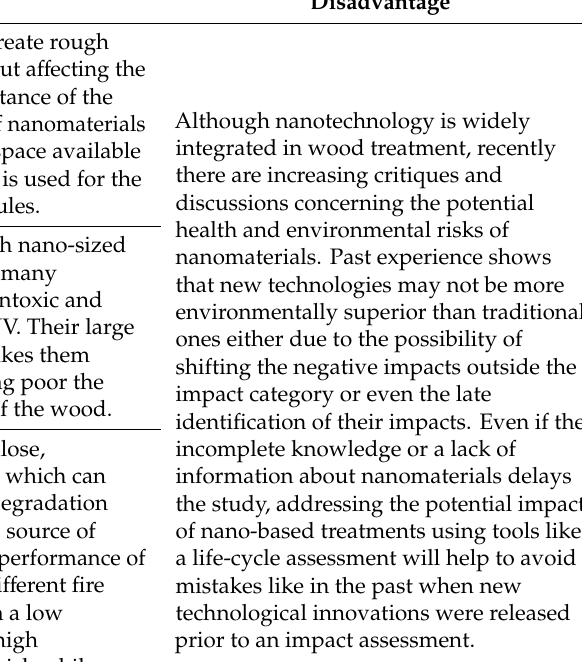
Table 1. The advantages of nanomaterials in wood preservation versus conventional